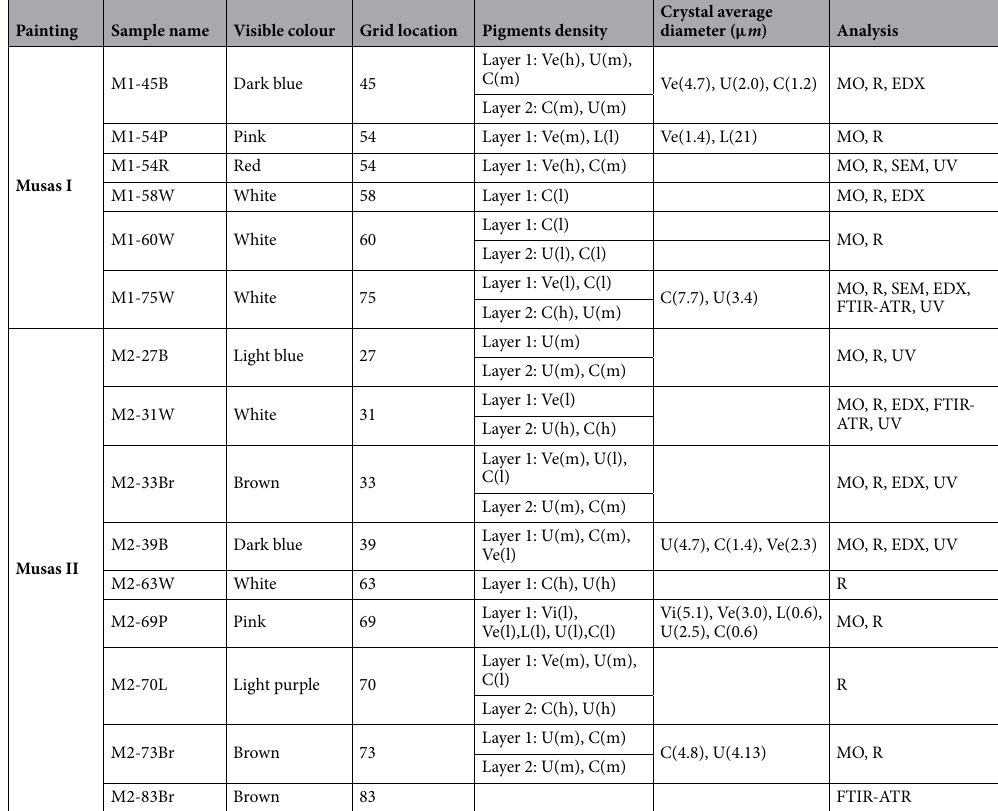
Table 1. Paint stratigraphy samples. Pigment density, observed through optical microscopy, is categorized as l = low, m = medium or h = high, for each type of pigment: L = lead red, Vi = viridian, U = ultramarine, Ve = vermilion and C = chrome yellow. The average diameter of the crystals, in micrometers, is indicated in parenthesis next to the pigment symbols. Analysis symbology: OM = optical microscopy, R = Raman spectroscopy, EDX = energy dispersive X ray spectroscopy, UV = fluorescence microscopy and FTIR-ATR = Fourier transform infrared - attenuated total reflectance spectroscopy. For FTIR-ATR analysis, samples were not embedded. The rest of the analyses were carried out on cross-sections of